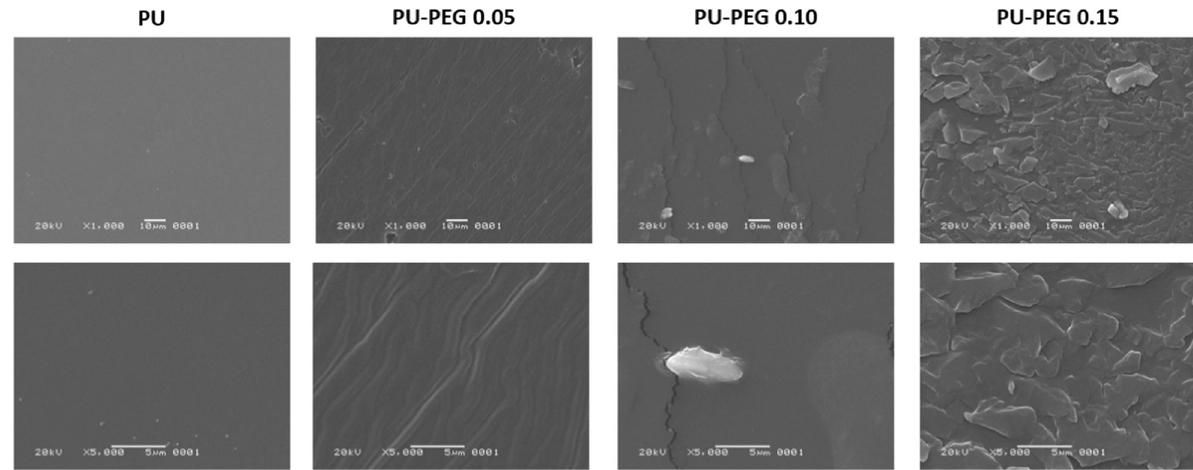
Fig. 5 SEM images of the grafted fi lms. A PEG covering is formed on the surface of the substrata